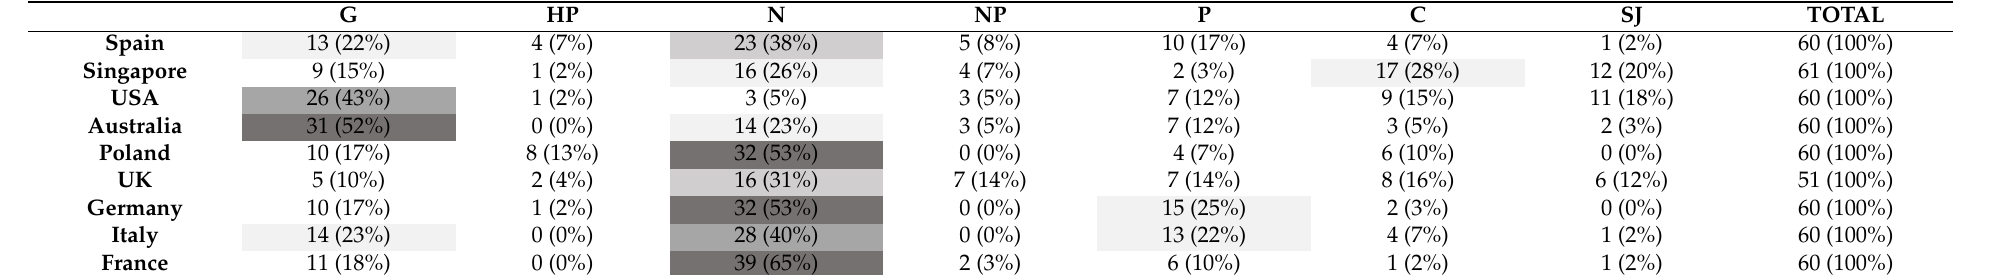
Table 2. Composition of the search engine result page (SERP) by typology of webpages for keywords: “COVID-19”, “Coronavirus”,